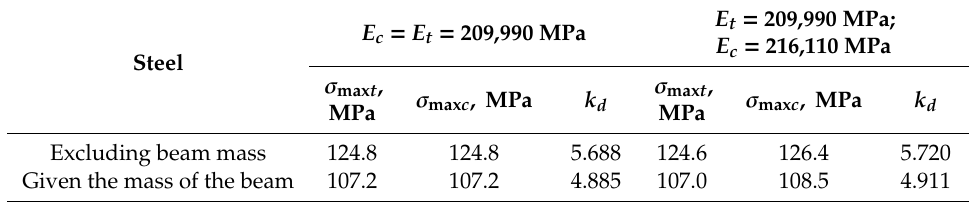
Table 4. Maximum normal stresses ( σ max t , σ max c ) and dynamic coe ffi cient ( k d ) of a steel beam.